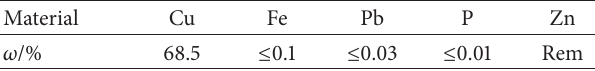
Table 1: Chemical composition of CuZn33.